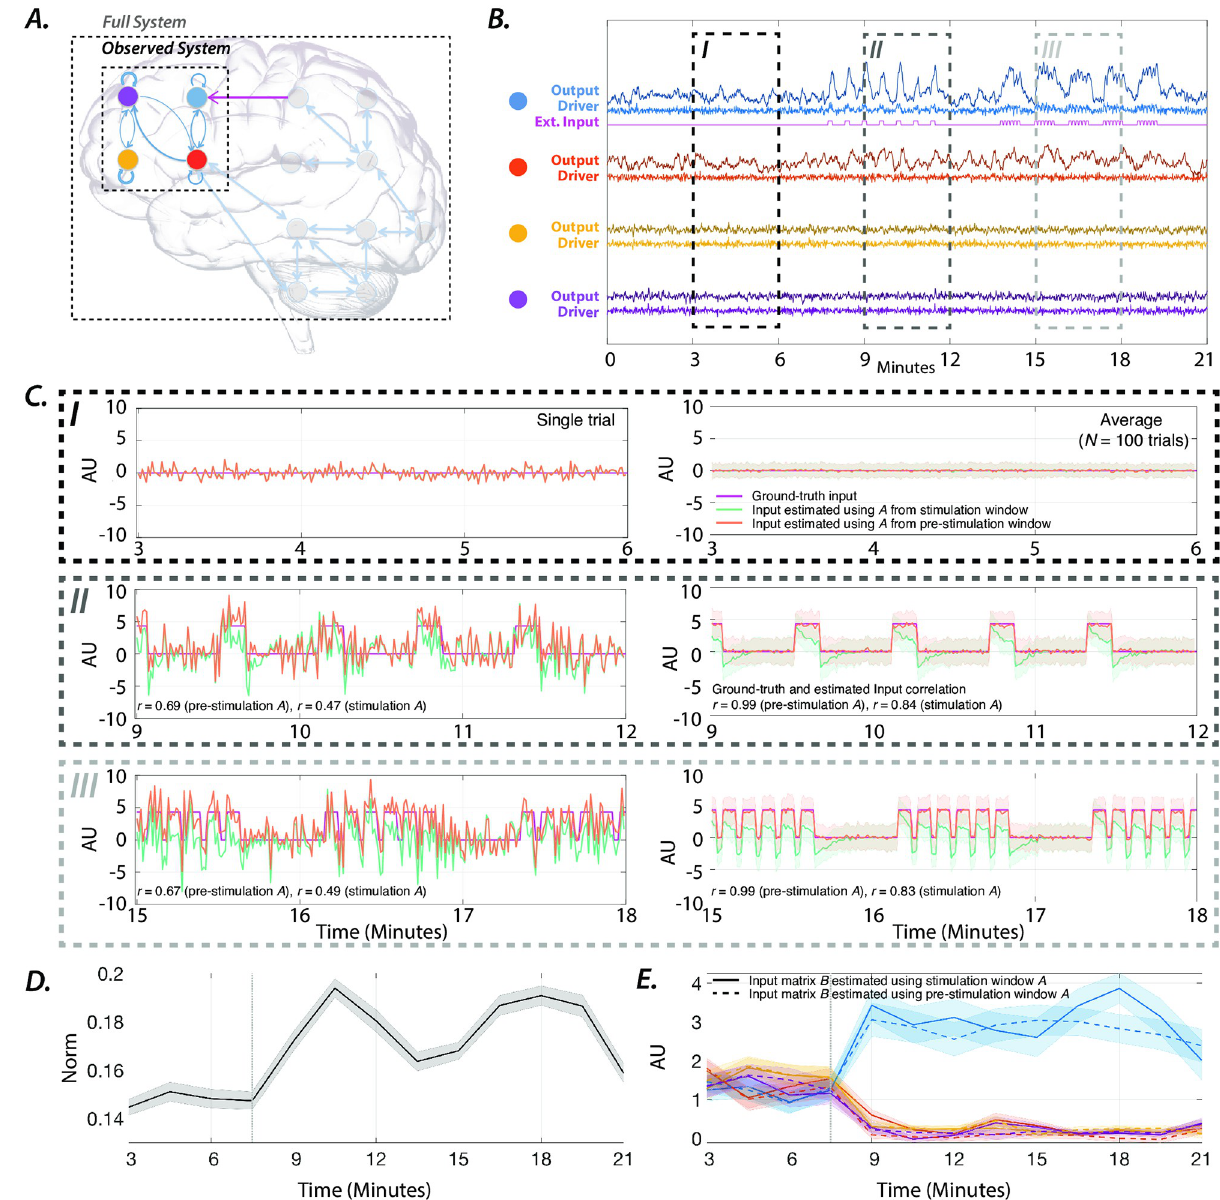
Fig 1. Synthetic LTI system with unknown inputs. (A) A schematic of the brain as a network, where the nodes represent brain regions, and the edges represent connections between regions. The activity of four observed regions is modeled as a four-dimensional LTI system, and the influence of the unobserved regions and external stimuli into each node as an unknown driver. The synthetic system matrix is designed with eigenmodes oscillating at 0.01 and 0.06 Hz to mimic the frequencies of BOLD signal’s neurophysiological component. (B) Simulated time-evolution of each node’s activity (sampling rate = 1.4 Hz) is color-coded and shown in the presence of drivers, namely the internal noise and the external input (brighter colors). Only the blue node receives external input indicated by the magenta line. Three periods (I–III) are highlighted dashed lines. At period I (3–6 min), there is no external stimulation. At period II (9–12 min), the blue node is stimulated in 25 samples = 18 seconds blocks, interleaved with similarly sized rest periods. At period III (15–18 min), the blue node is stimulated for 7 samples = 5.04 seconds, with inter-stimulus intervals of 3 samples = 2.16 seconds. (C) Left panels show the estimated inputs to the blue node (green line, arbitrary units AU) estimated from a single simulation. The panels on the right show the average input and its standard error over 100 simulations. (D) The average 2-norm and standard error of the difference between the system’s true and estimated matrices of a 3-minute sliding window. (E) The color-coded lines show the average (and standard error) loading of each node on input matrix B .